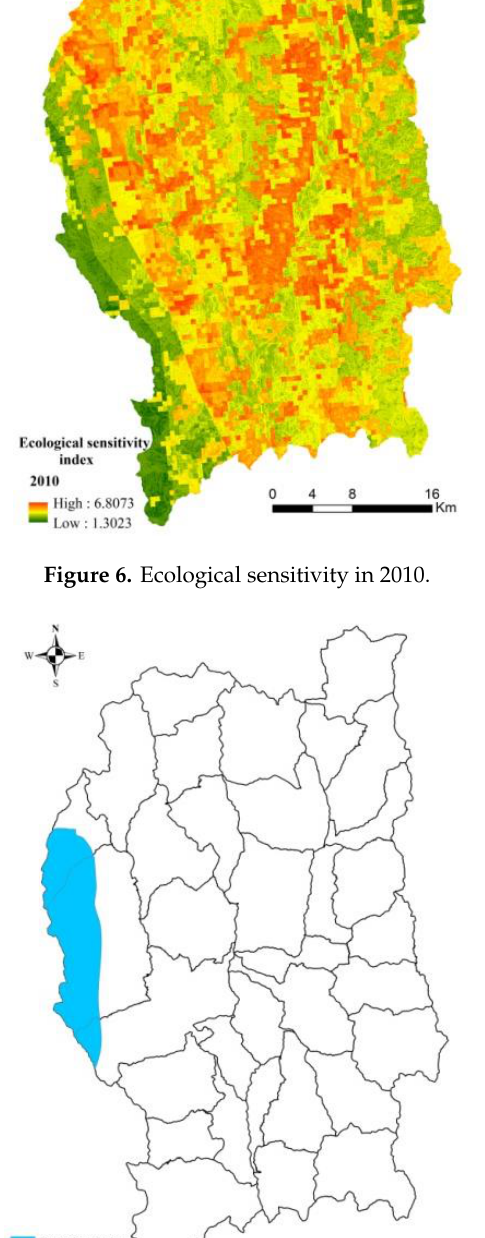
Figure 7. Restricted area of Puge County.